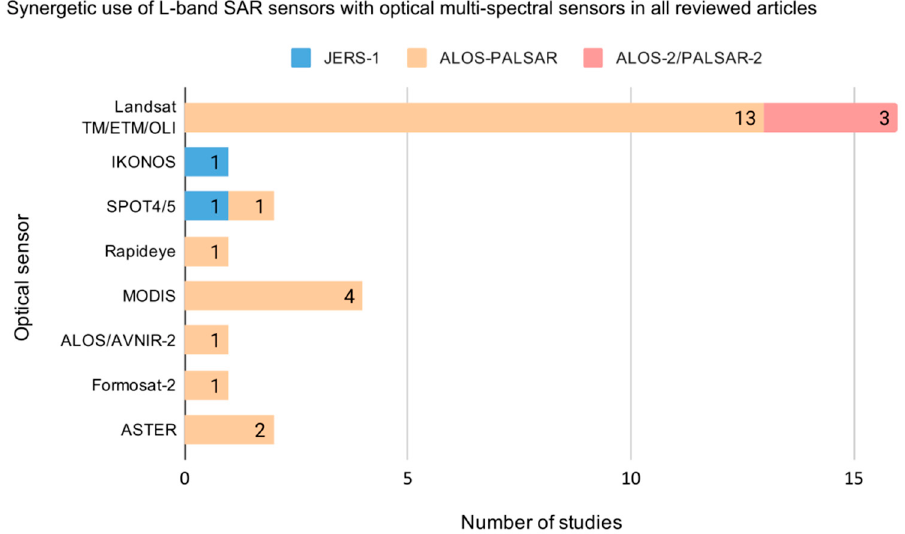
Figure 8. Number of reviewed studies with synergetic L-band SAR and optical remote sensing data.